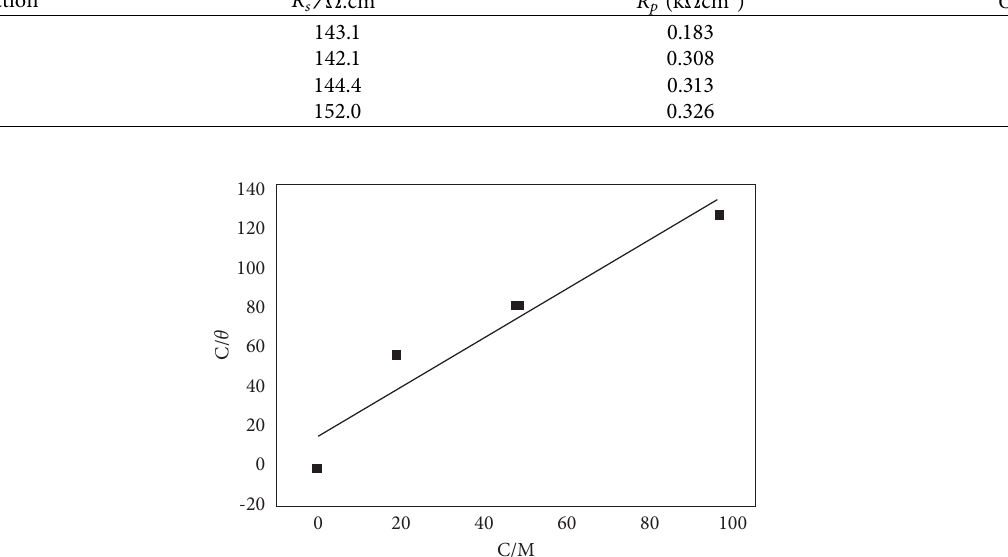
Figure 16: Langmuir isotherm plot for the adsorption of PSA on a mild steel surface in a stagnant, naturally aerated solution of 1M H at 25 ° C.